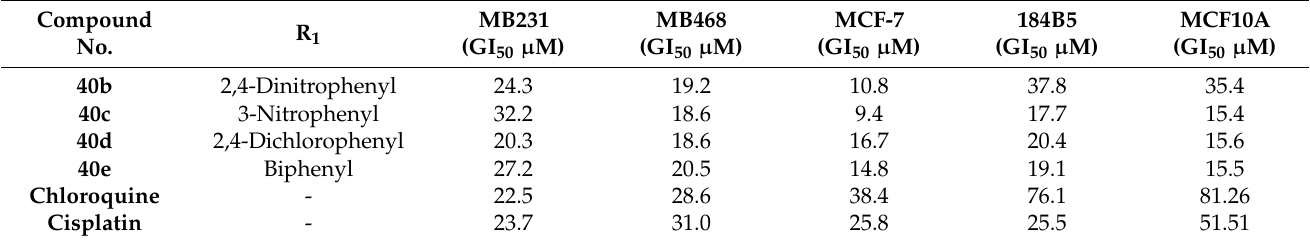
picted in Figure 45 [98].